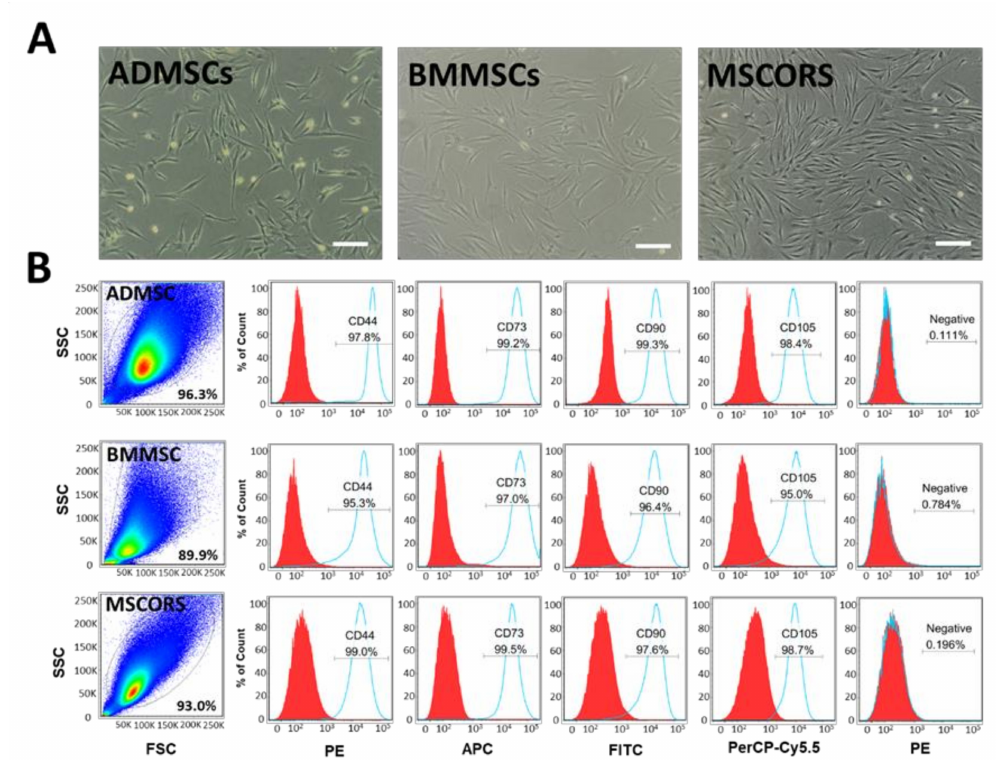
Figure 1. Phenotypic characterization and marker expression of adipose tissue-derived, bone marrow-derived and follicle outer root sheath-derived mesenchymal stem cells (MSCs) (ADMSCs, BMMSCs, and MSCORS). ( A ) Representative microphotographs of ADMSCs, BMMSCs, and MSCORS in culture at passage 2. ( B ) Representative histograms of the MSC marker expression levels against the isotype control in ADMSCs, BMMSCs, and MSCORS. FACS plots and histograms of representative labeling of ADMSCs, BMMSCs, and MSCORS with antibodies against human MSC surface markers CD44, CD73, CD90, CD105 (light blue bold curve) in comparison to labeling with the isotype control antibody (red filled curve). Negative markers included combination of the supplied negative MSC cocktail (PE CD45, PE CD34, PE CD11b, PE CD19, and PE HLA-DR). Scale bar: 200 µ m; Magnification ( A ) 4 ×